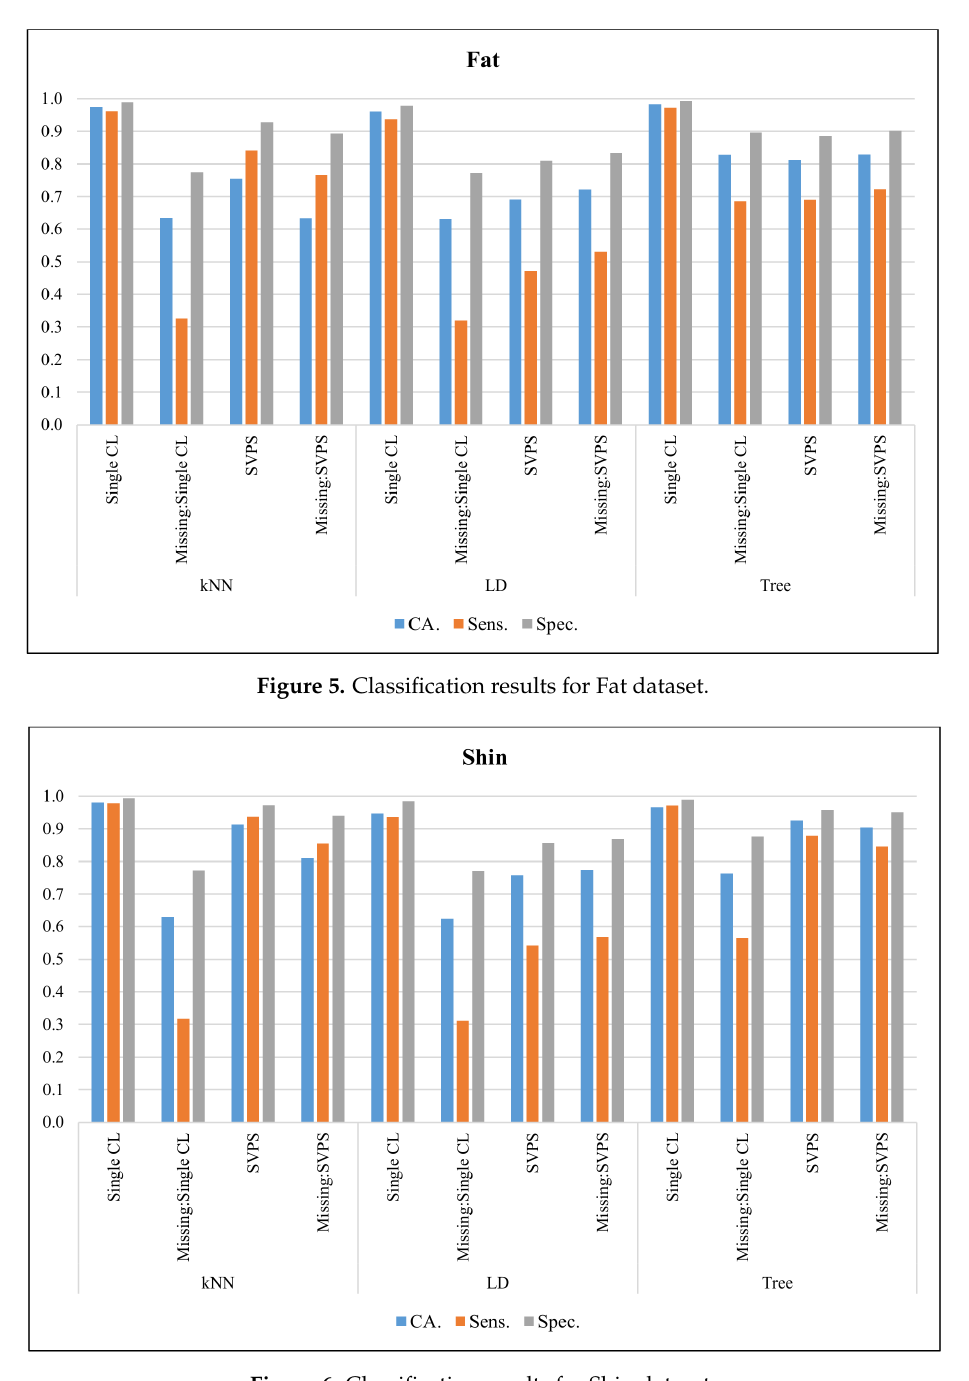
Figure 6. Classification results for Shin